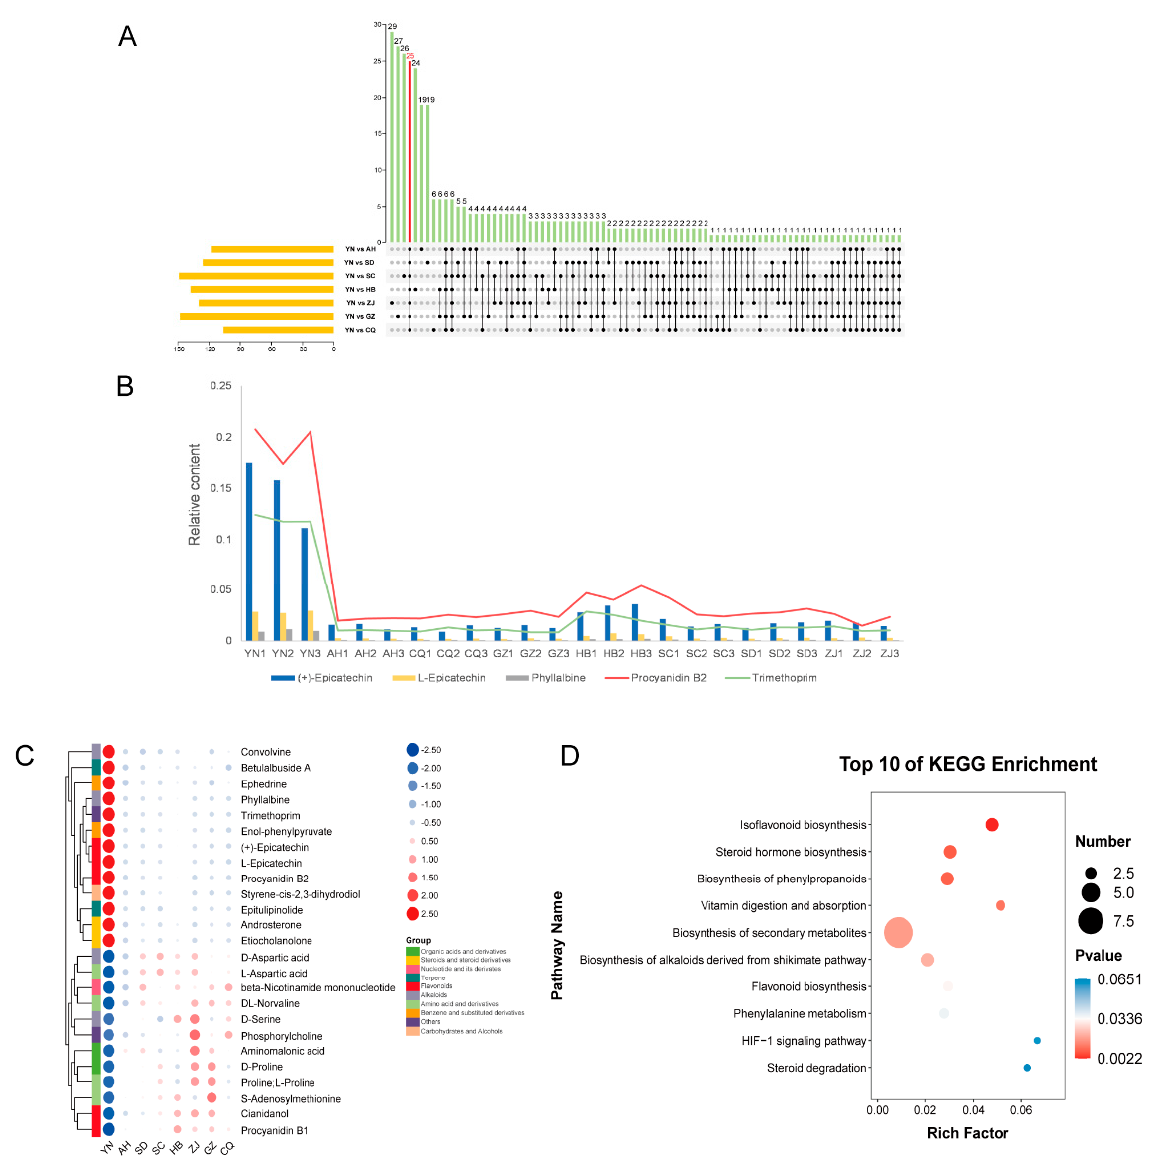
Figure 5. Comparison of differential metabolites between YN and other regions. ( A ) Upset diagram was applied to depict commonly expressed metabolites. ( B ) Five metabolites with the highest content in the shared metabolites. ( C ) Heat map of 25 common metabolites. ( D ) KEGG enrichment analysis of differential metabolites with higher content in